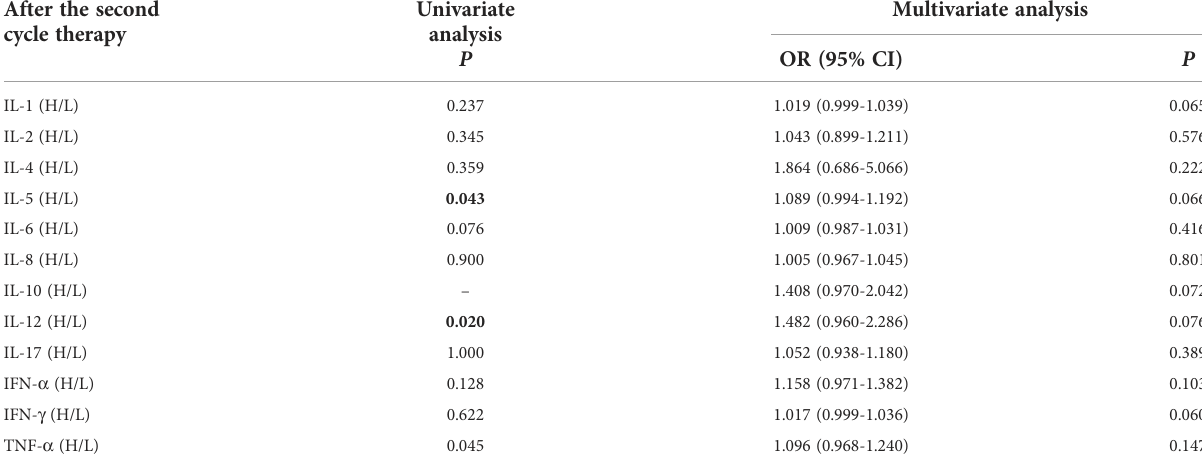
TABLE 4 Univariate and multivariate analysis results of cytokine levels after the second cycle therapy between AE and NAE.